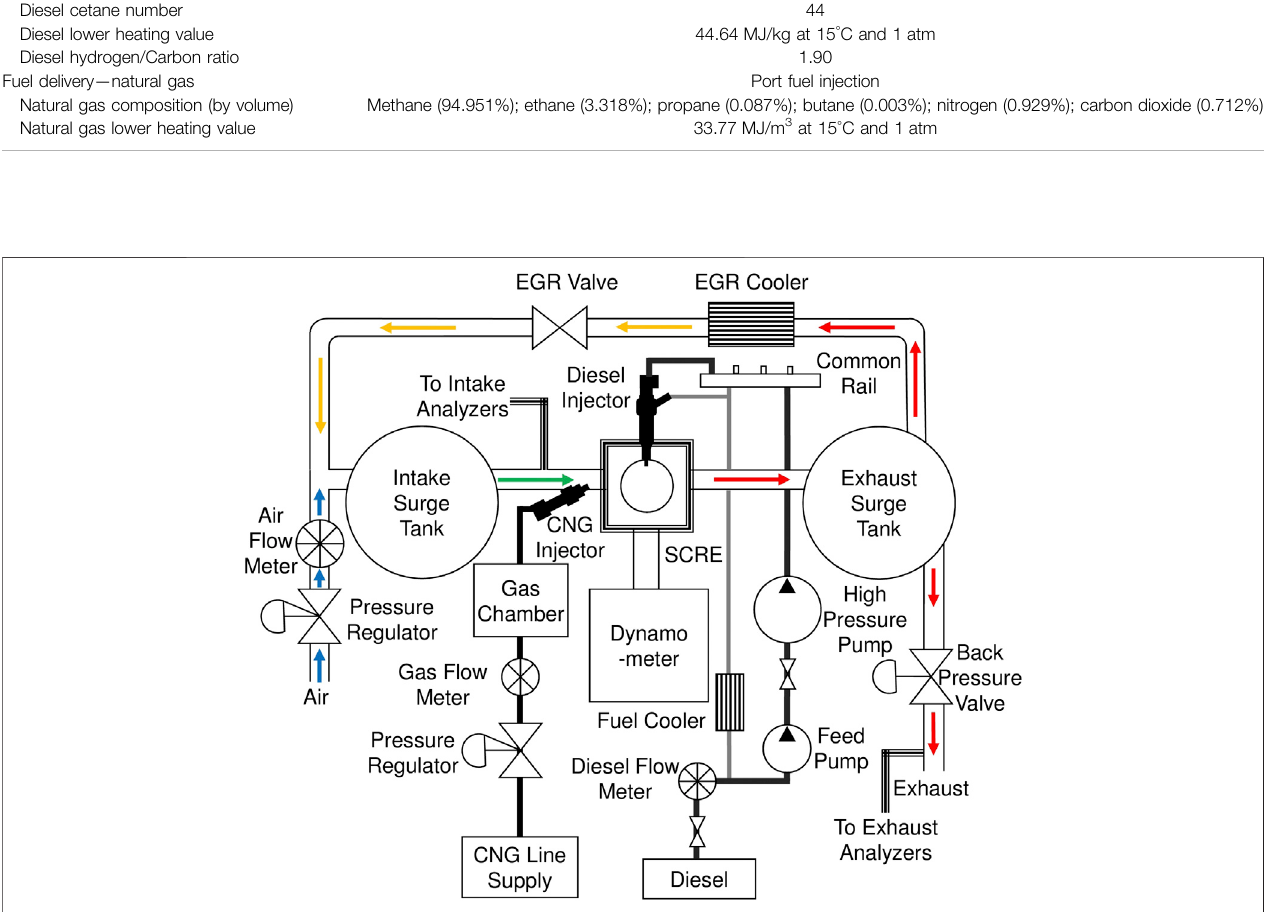
FIGURE 1 | Schematic of experimental